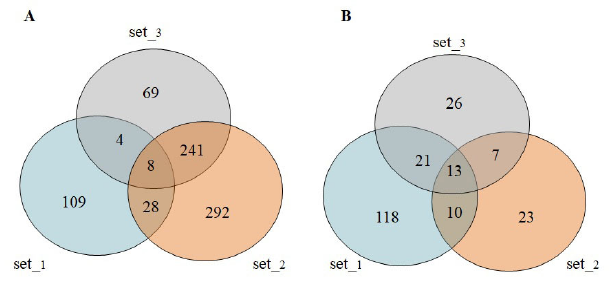
FIGURE 1 - Upregulated and downregulated common genes were identified from SHR, GK and HMR microarrays using TBtools software. (A) Set_1 represents 149 upregulated genes from the HMR group compared with the normal group; Set_2 represents 569 upregulated genes from the GK group compared with the normal group; Set_3 represents 322 upregulated genes from the SHR group compared with the normal group; The intersection of the three regions in the center represents 8 common upregulated genes in SHR, GK and HMR groups compared with the normal group; (B) Set_1 represents 162 downregulated genes in the HMR group compared with the normal group; Set_2 represents 53 downregulated genes in the GK group compared with the normal group; Set_3 represents 67 downregulated genes in the SHR group compared with the normal group; The intersection of the three regions in the center represents 13 common downregulated genes in SHR, GK and HMR groups compared with the normal group.